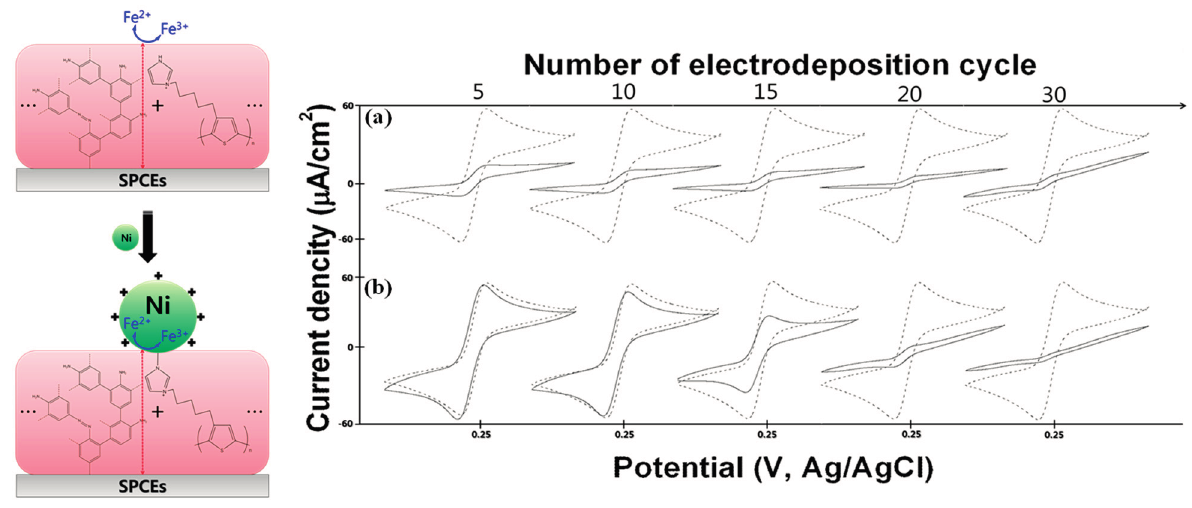
Figure 5. Differential pulse voltammograms of the SPCEs/Organic film/Ni/Fe-HA with variable anti-HA (0 ~ 5 mg mL − 1 ). Inset shows the calibration curve of the cathodic DPV peak current of SPCEs/Organic film/Ni/Fe-HA at 0.45 V versus Ag/AgCl as a function of the anti-HA